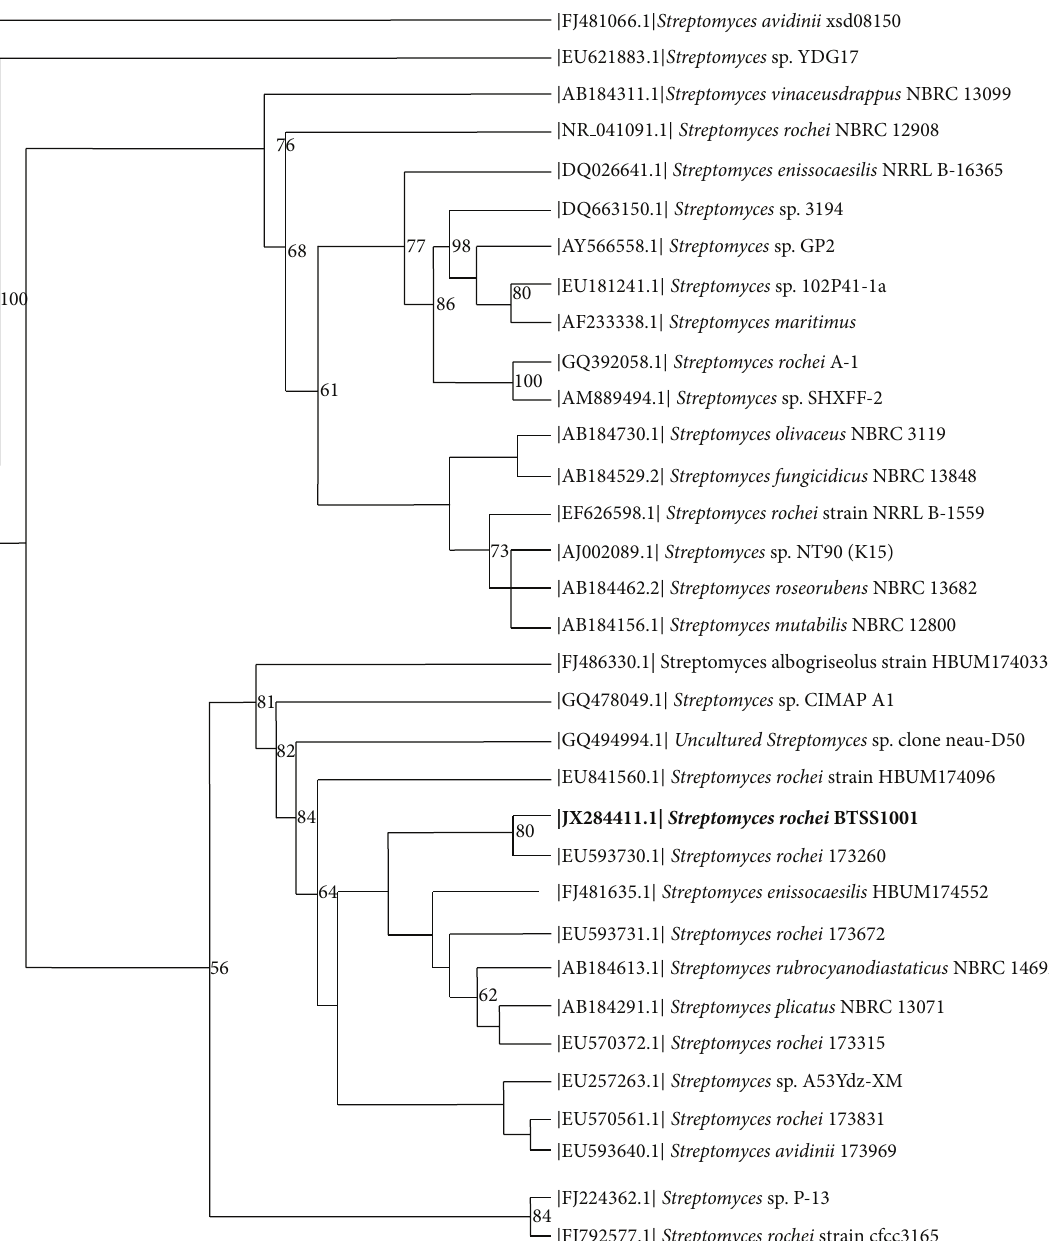
Figure 8: Phylogenetic tree of strain BTSS 1001 and its closest relatives within the family Streptomycetaceae, reconstructed by using the neighbour-joining method, based on 16S rRNA gene sequences. Numbers at nodes are bootstrap percentages based on 1000 resamplings (only values of 50% or more are